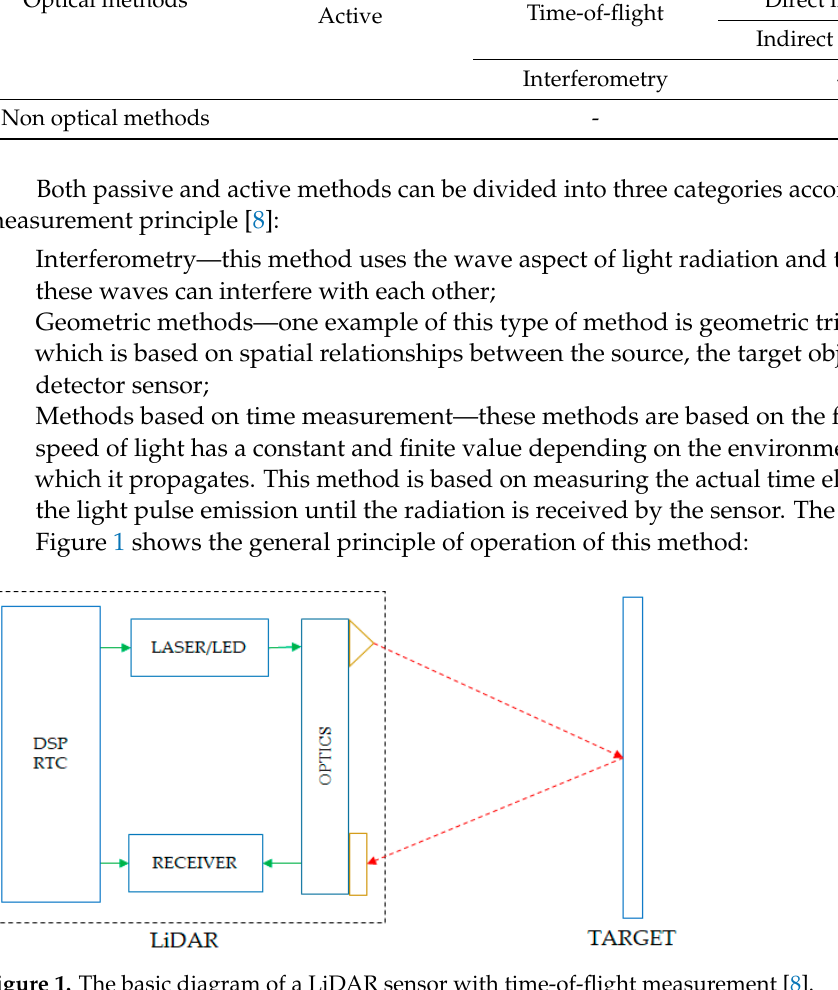
where c is the speed of light, and T is the total time of flight of the radiation